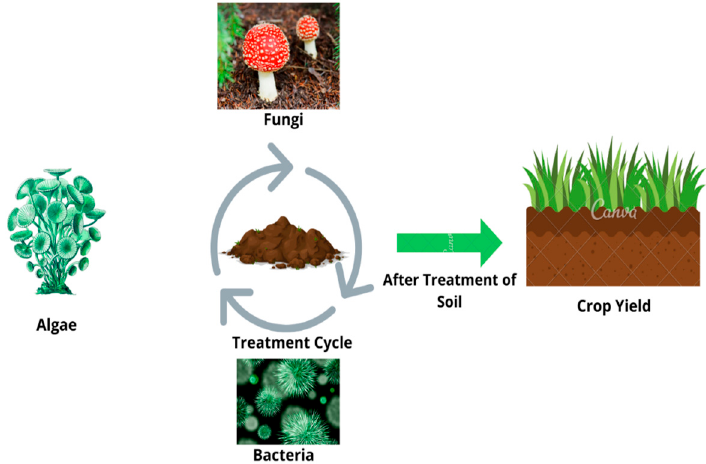
Figure 3. Bioremediation process showing the role of algae, fungi, and bacteria for the enhancement of soil health.